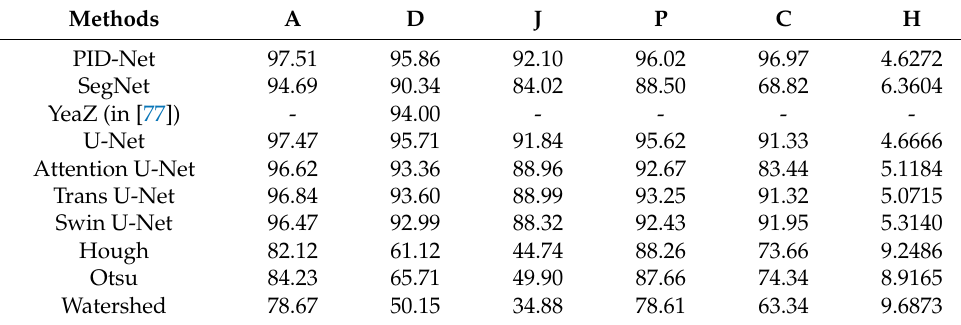
Table 4. The average segmentation evaluation indices of predicted images. A, D, J, P, C and H are abbreviations of the Accuracy, Dice, Jaccard, Precision, Counting Accuracy (in %) and Hausdorff Distance (in pixels/per image),